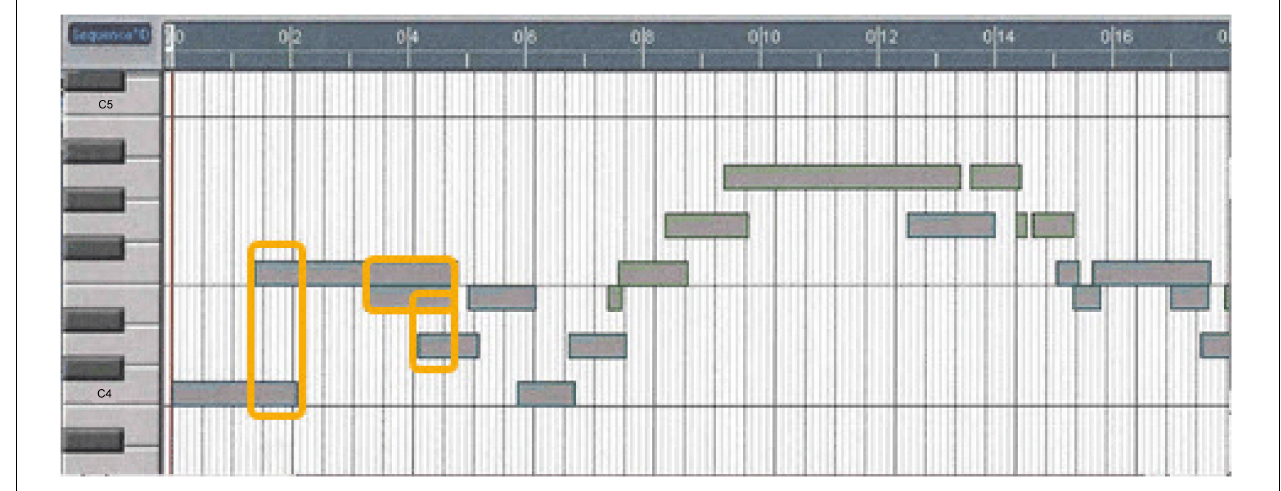
FIGURE 10 | Sonification of note bar overlap in melody, measures 1–6.